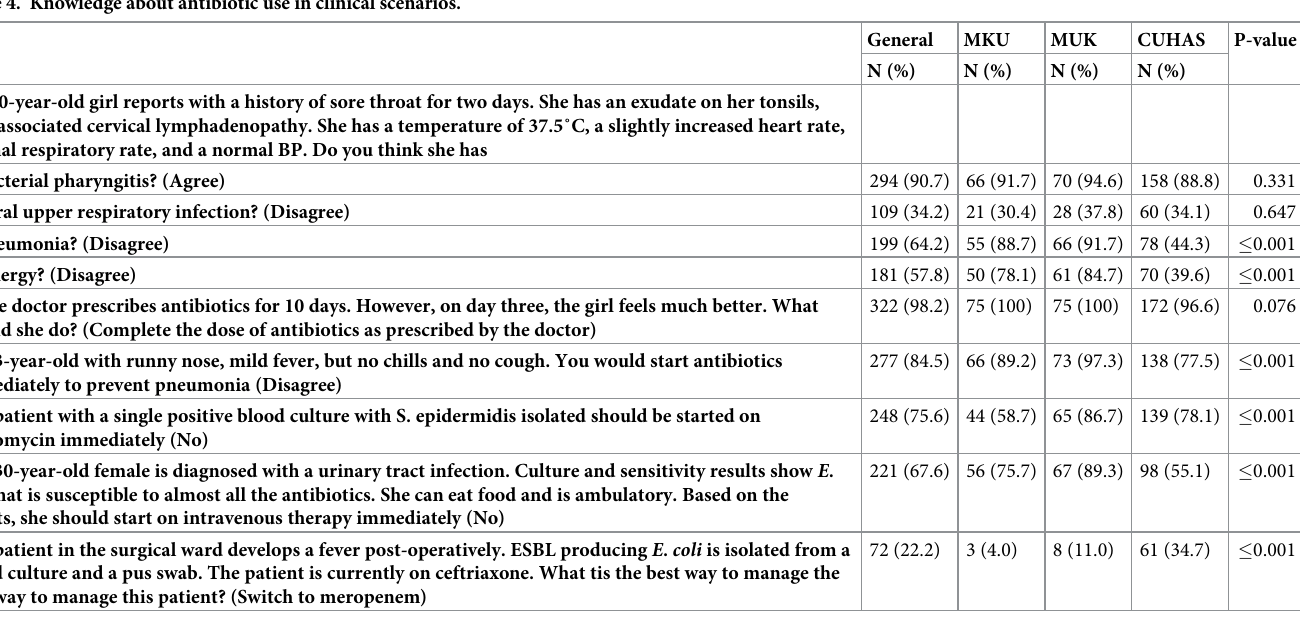
Table 4. Knowledge about antibiotic use in clinical scenarios.